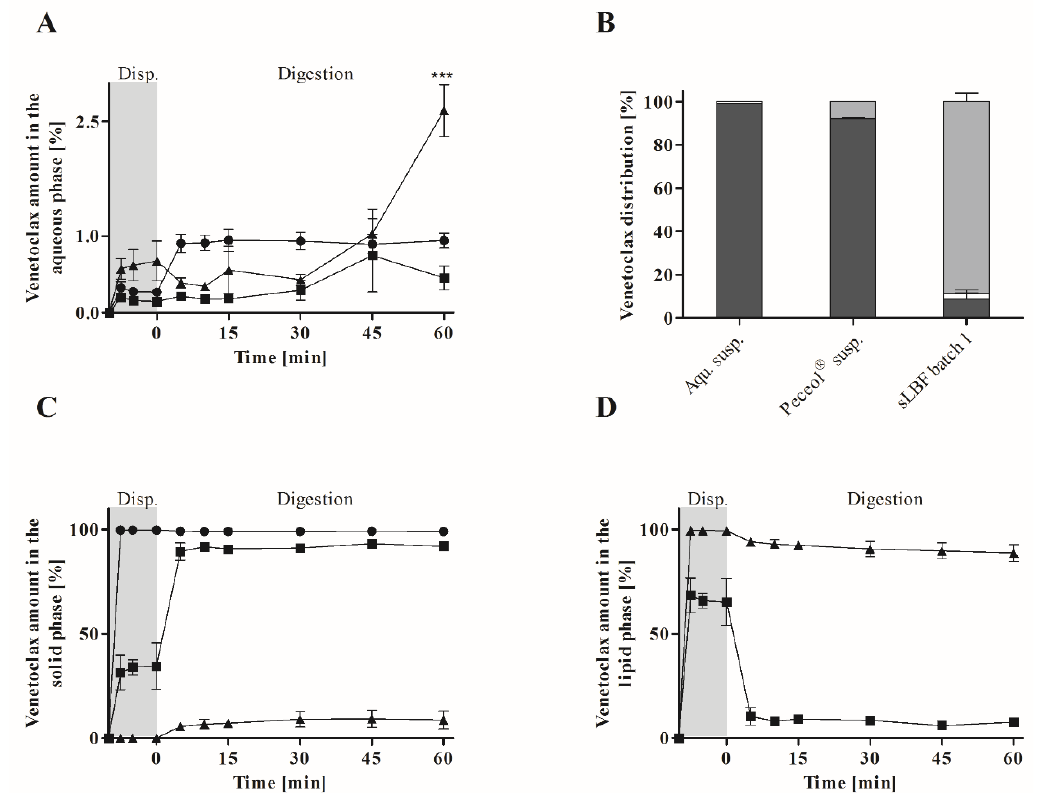
Figure 4. In vitro lipolysis of venetoclax formulated as an aqueous suspension (5% w / v ) (●), a Peceol ® suspension (5% w / v ) ( ■ ), and a supersaturated Peceol ® solution (sLBF) (5% w / v ) ( ▲ ). ( A ): % of venetoclax in the aqueous phase. Statistical significance is compared to Peceol ® and the aqueous suspension. ( B ): Distribution of venetoclax into the different phases after 60 min of lipolysis. ( C ): % of venetoclax in the solid phase. ( D ): % of the venetoclax in the lipid phase. All experiments were run with n = 3 and results are shown as the mean ± SD. Statistical difference is indicated as ***, where p ≤ 0.001.